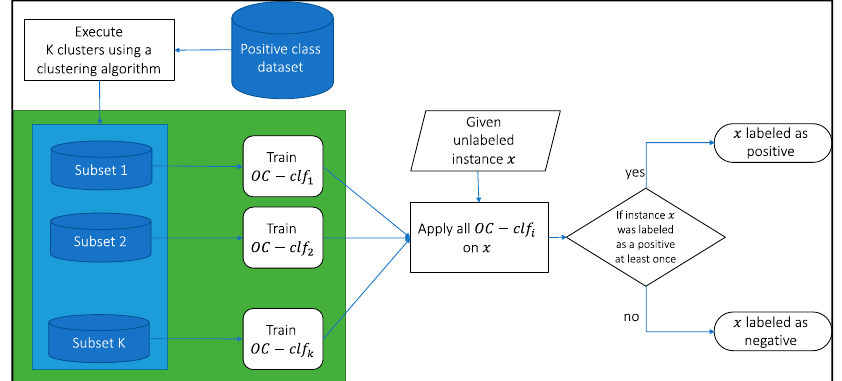
Figure 3. Illustration of the proposed method. Firstly the algorithm clusters the positive dataset